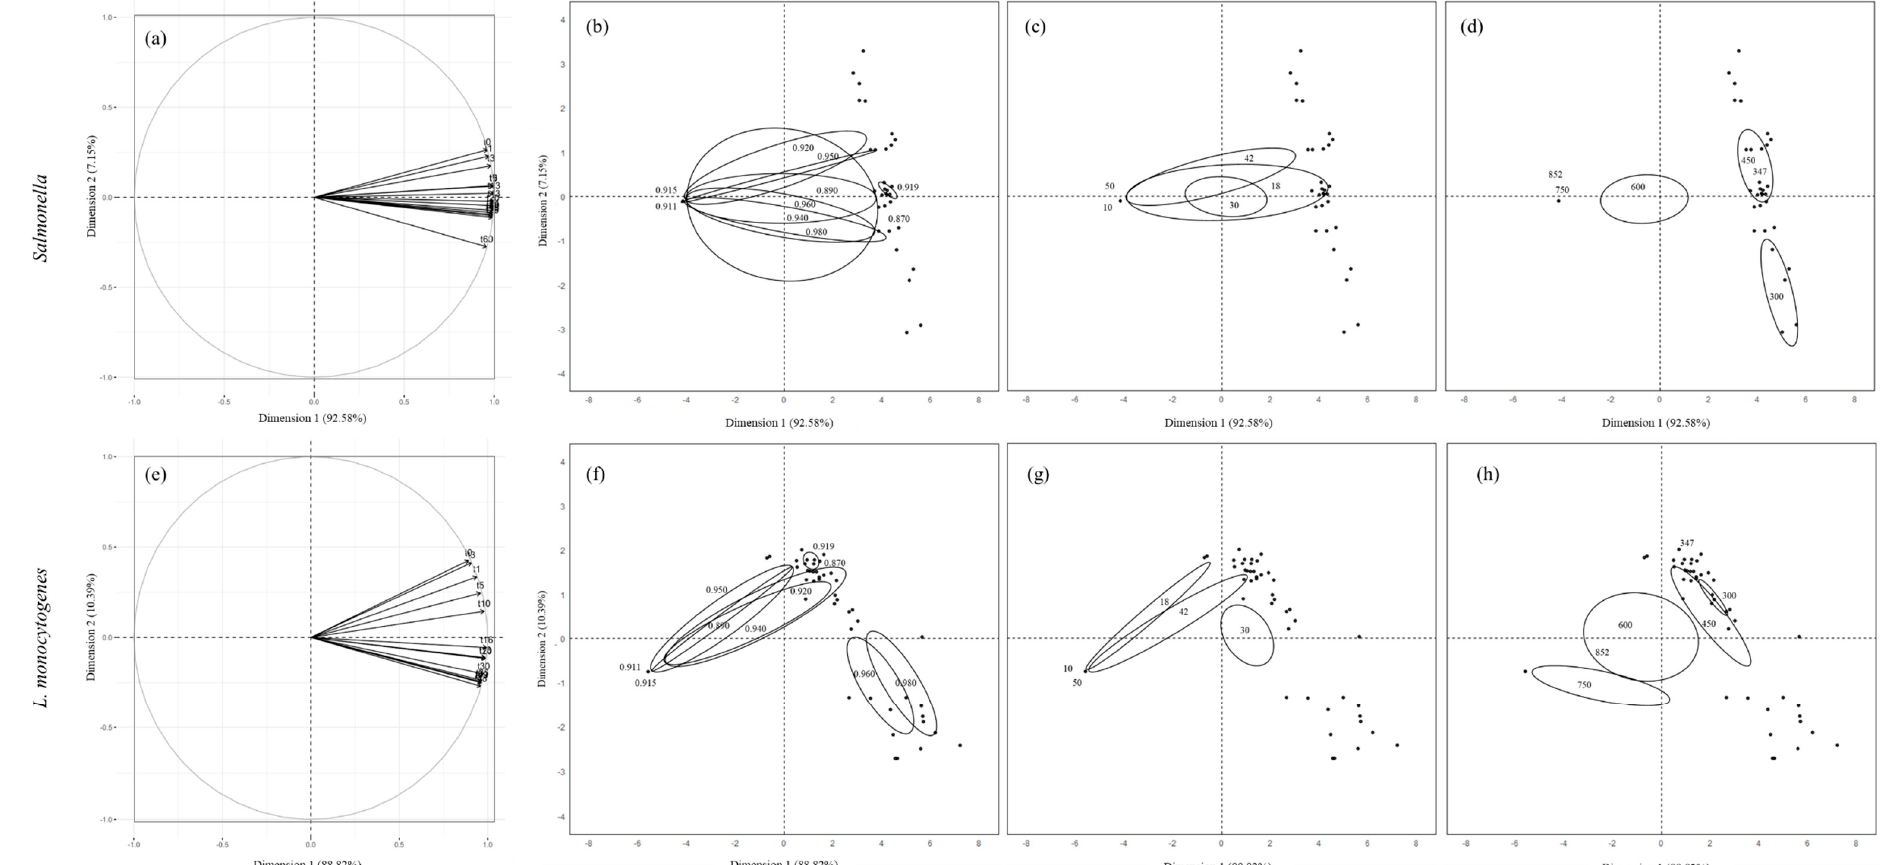
Figure 3. Results of the principal component analysis (PCA) performed on the log change values of Salmonella ( a , b , c , d ) and L. monocytogenes ( e , f , g , h ) observed during the storage of pressurized dry-cured ham (DCH) at 7 °C. ( a , e ) show the correlation circles with the relationship between all the sampling times (days) on the log change data of Salmonella and L. monocytogenes . In ( b , c , d , f , g , h ), the points represent the scores for the first two dimensions of PCA corresponding to each replicate of the 32 trials performed and the ellipses correspond to confidence ellipses at a confidence level of 0.95 around the categoric variables a w ( b , f ), % of fat content ( c , g ), and pressure level in MPa ( d , h ).